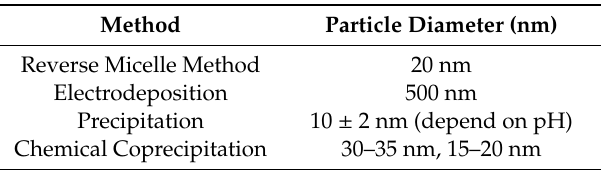
Table 12. Particle diameter with each chemical method.